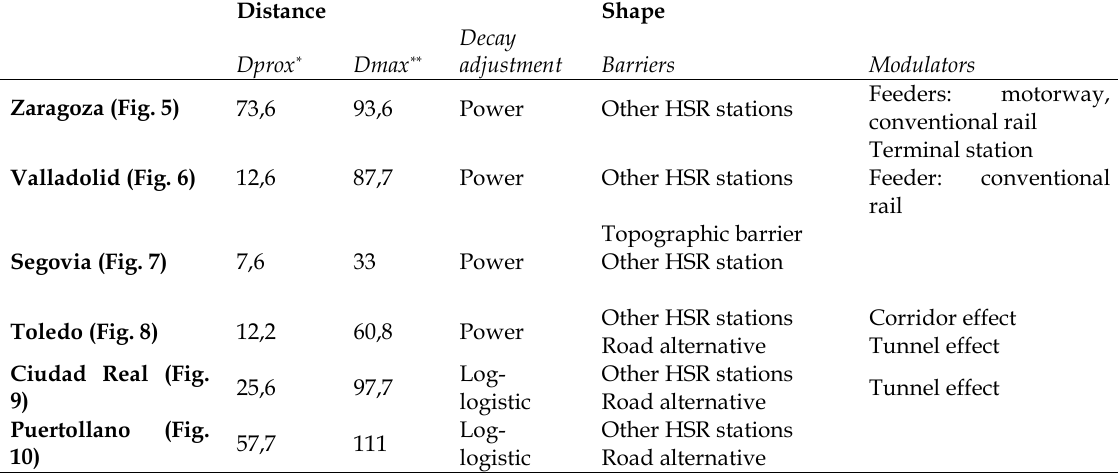
Table 5. Summary of